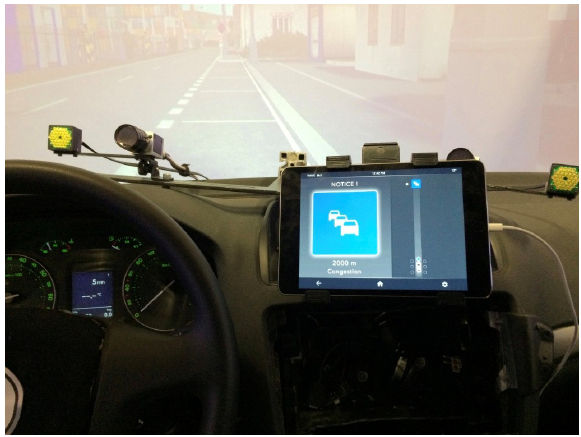
Figure 4. The tablet device within the cockpit.